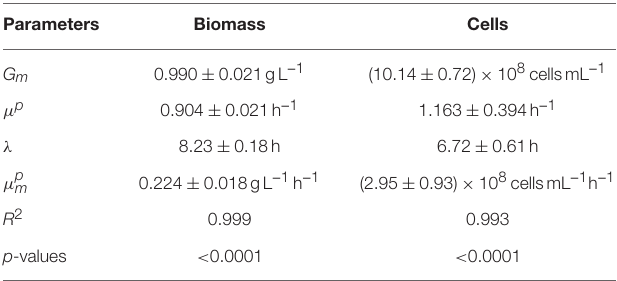
Statistical parameters R 2 and p-values are also shown.